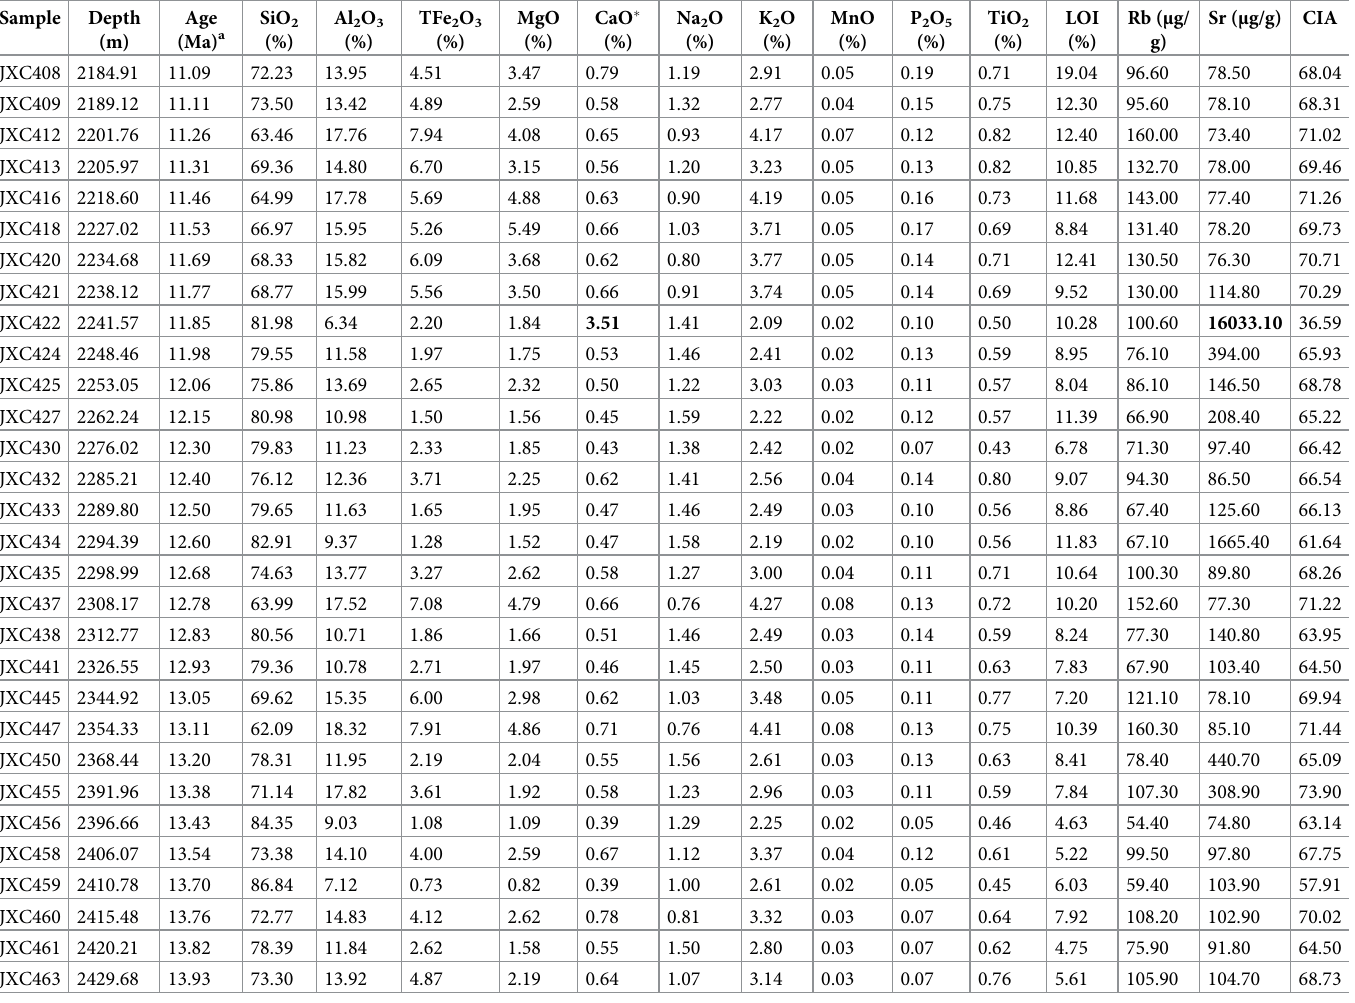
Table 1. Major and trace element composition of the fluviolacustrine sediments in Sikouzi section.